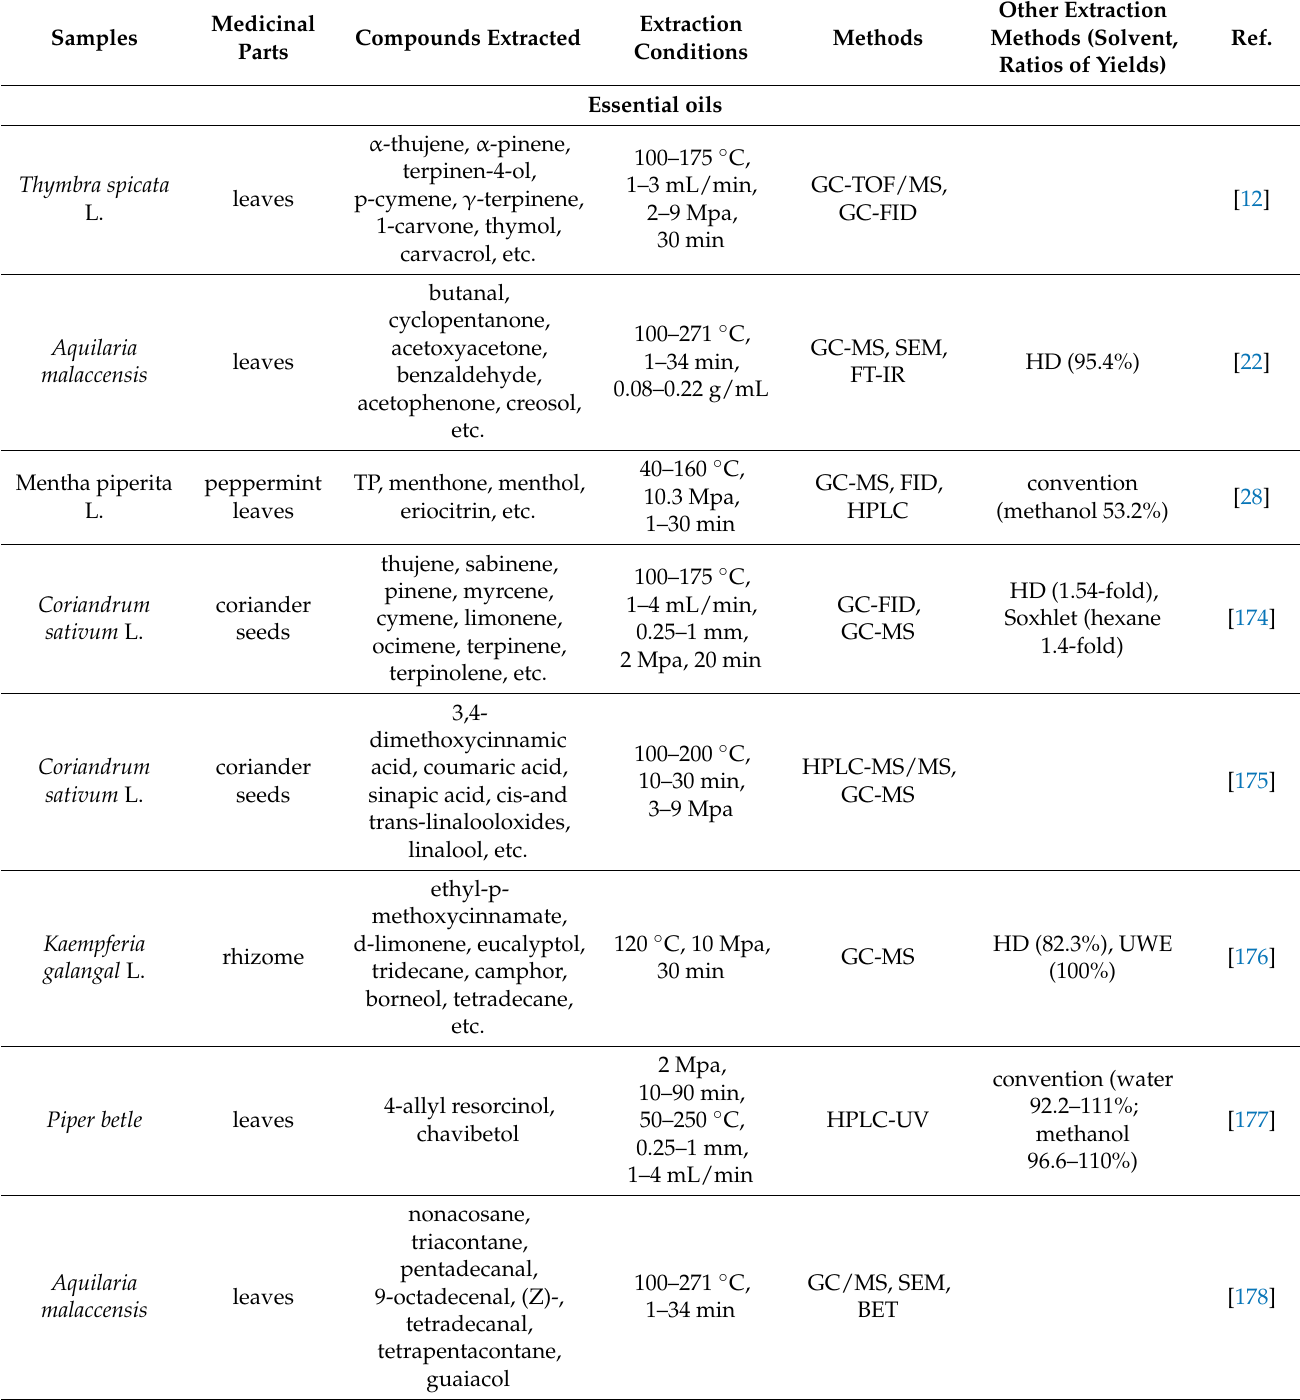
Table 6. SBWE of essential oils, alkaloids, quinones, terpenes, lignans, and